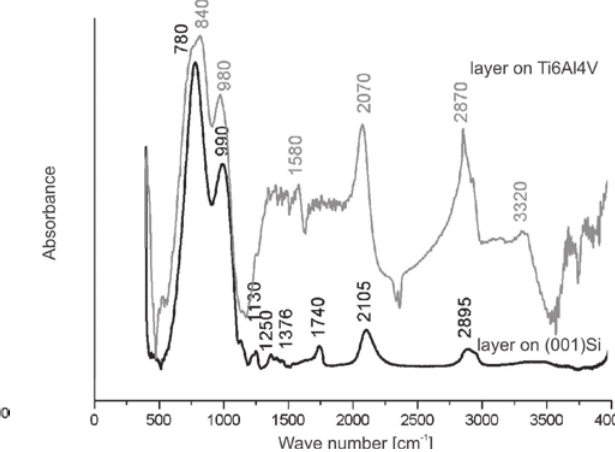
Fig. 9: FTIR spectra for SiC x N y (H)/(001)Si and SiC x N y (H)/alloy synthesis in series 3.